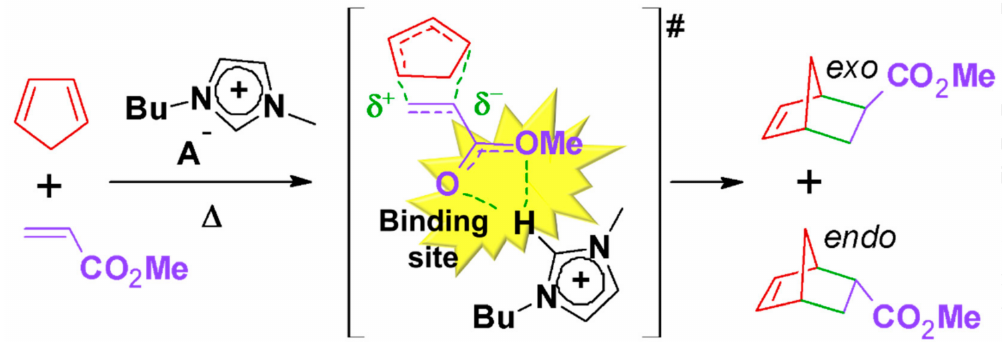
Figure 39. A Diels–Alder reaction of methyl acrylate with cyclopentadiene to give a mixture of endo- and exo-bicyclo-[2.2.1]-hept-5-ene-2-carboxylic acid methyl ester and the activated complex of the reaction (A = BF 4 , PF 6 , ClO 4 , TfO, NTf 2 , CF 3 CO 2